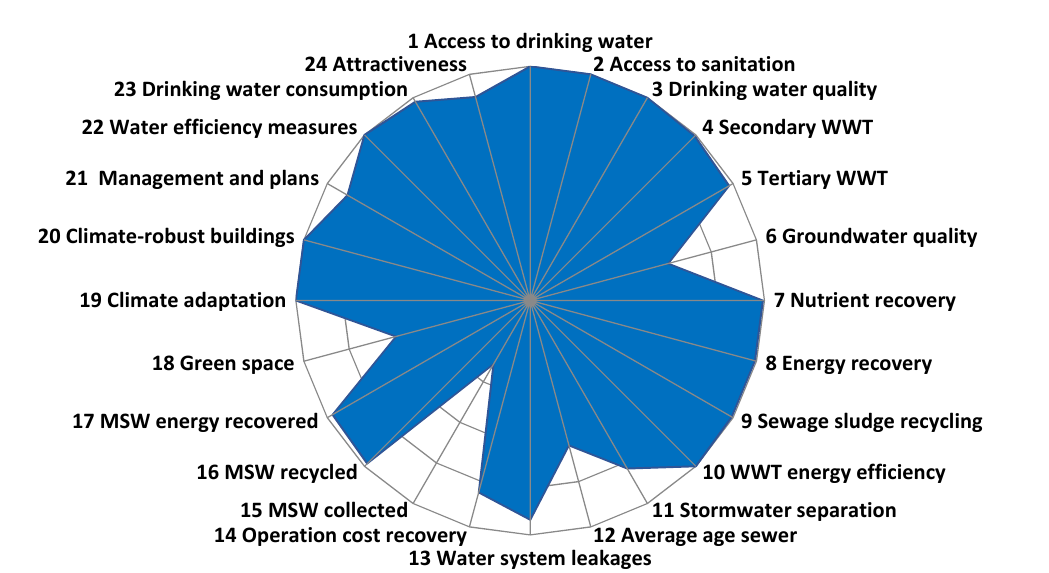
Figure 3. City Blueprint of Amsterdam (2020), assessed according to [15]. WWT, wastewater treatment.